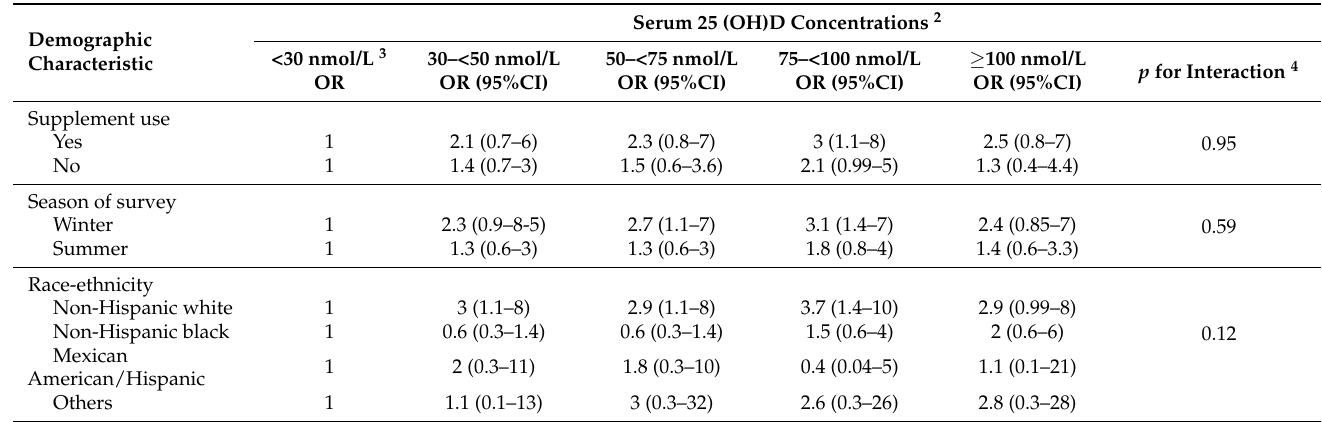
Table 4. Association of breast cancer with serum 25-hydroxyvitamin D [25(OH)D] concentrations according to supplement use, season of survey, and race-ethnicity in postmenopausal women in the USA: National Health and Nutrition Examination Surveys 2001–2014 (n = 8108) 1